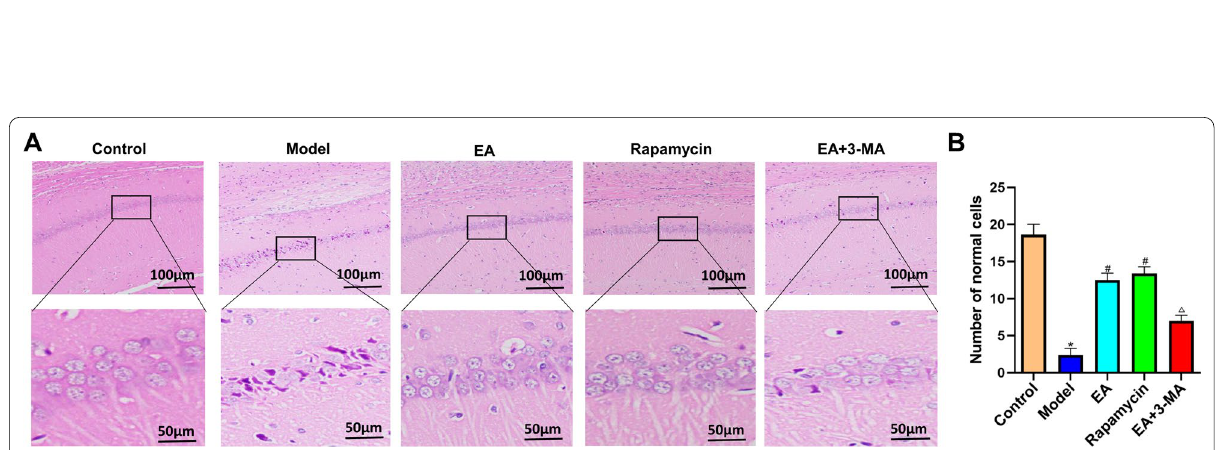
Fig. 4 Effects of EA on morphological changes in the hippocampal CA1 area. a HE staining of hippocampal CA1 area. Upper lane, Scale bar 100 μm, magnification 200. (the inside area of the red black rectangle. Scale bar = × in the CA1 area of the hippocampus controls had spherical and plump nuclei, clear nucleoli, and cytoplasm. The model group hippocampus neurons were loosely packed, fusiform or polygonal in shape, with irregular nuclei. Some of the neurons displayed karyopyknosis, hyperchromatic cytoplasm, and fuzzy or missing nucleoli. These morphological alterations were greatly improved in the EA, rapamycin, and EA with the EA group showing the greatest improvement. b Comparison of the number of normal cells in all groups. Data are expressed as mean standard error of the mean ( n 8 in each group). * p < 0.05 versus control group; # p < 0.05 versus model group; △ p < 0.05 versus EA ± =